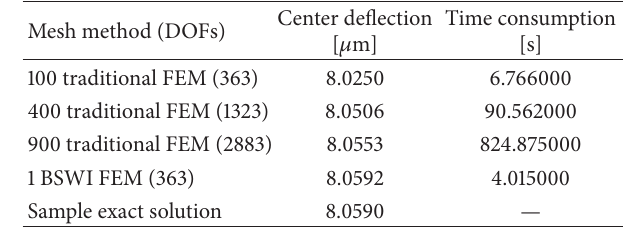
Table 4: Comparison of center deflection of the clamp supported Mindlin plate under uniform load (stochastic analysis).